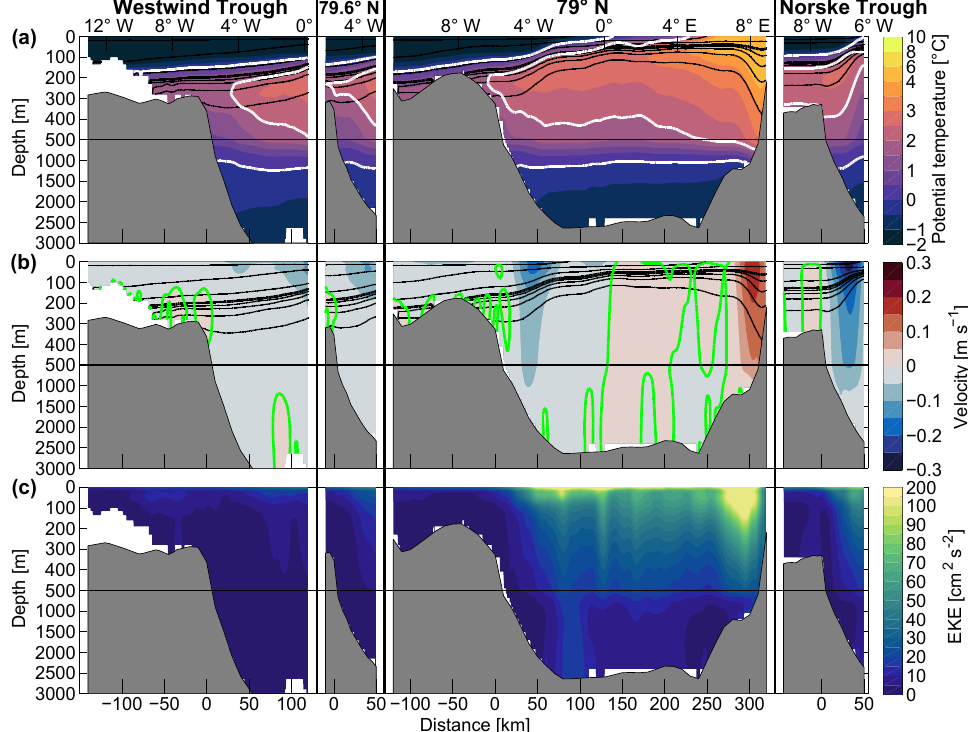
Figure 4. Eight year July/August/September average FESOM realizations of the sections crossing the east Greenland shelf break for (a) Po- tential temperature (as in Fig. 3a), (b) velocity (as in Fig. 3c) and (c)